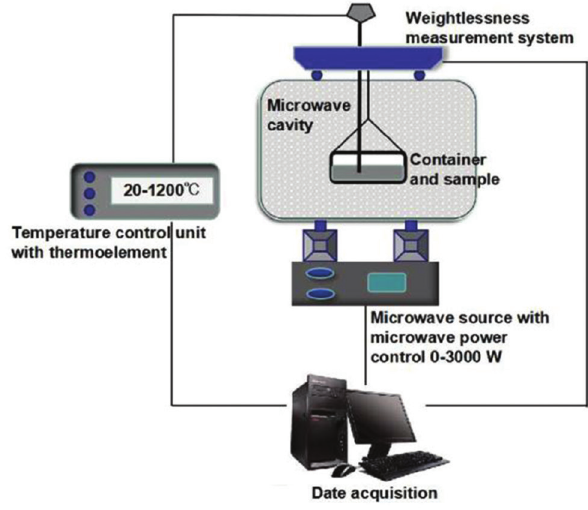
Figure 3: Schematics of microwave drying system.